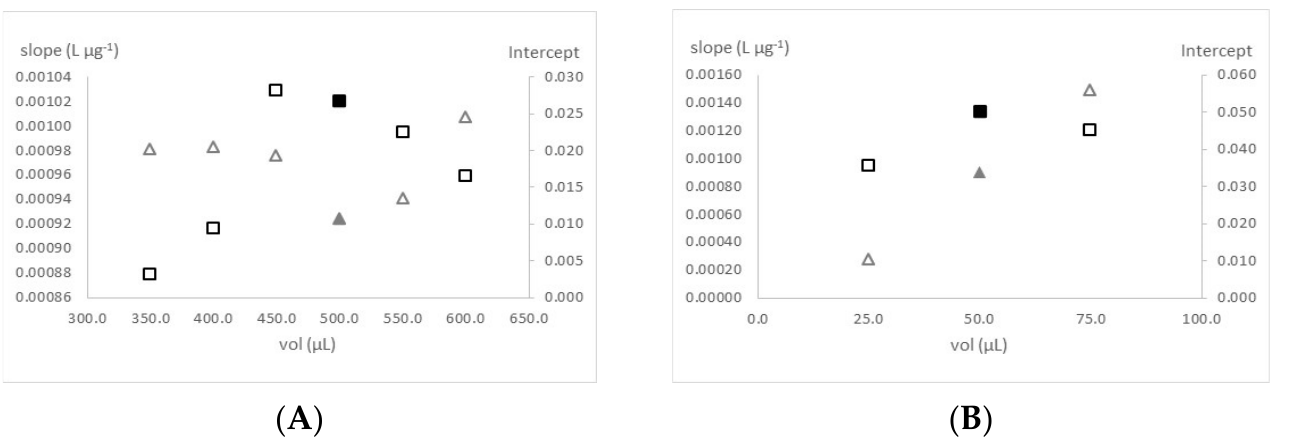
Figure 1. Study of the influence of the sample volume ( A ) and DPC reagent volume ( B ) on the method sensitivity, expressed as the calibration curve slope (squares), and on the calibration curve intercept (triangles). The chosen values are represented by solid-filled markers.